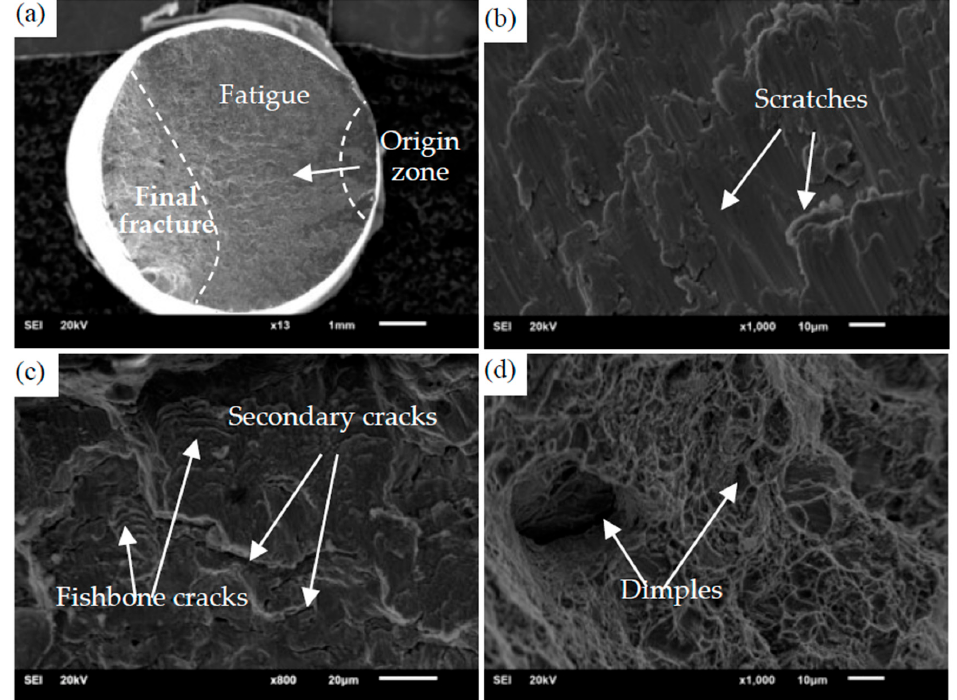
Figure 7. SEM images of the fracture. ( a ) Overall fracture morphology; ( b ) the morphology of crack origin zone and extension zone; ( c ) the typical morphology of crack propagation zone; ( d ) the typical morphology of transient fracture zone.